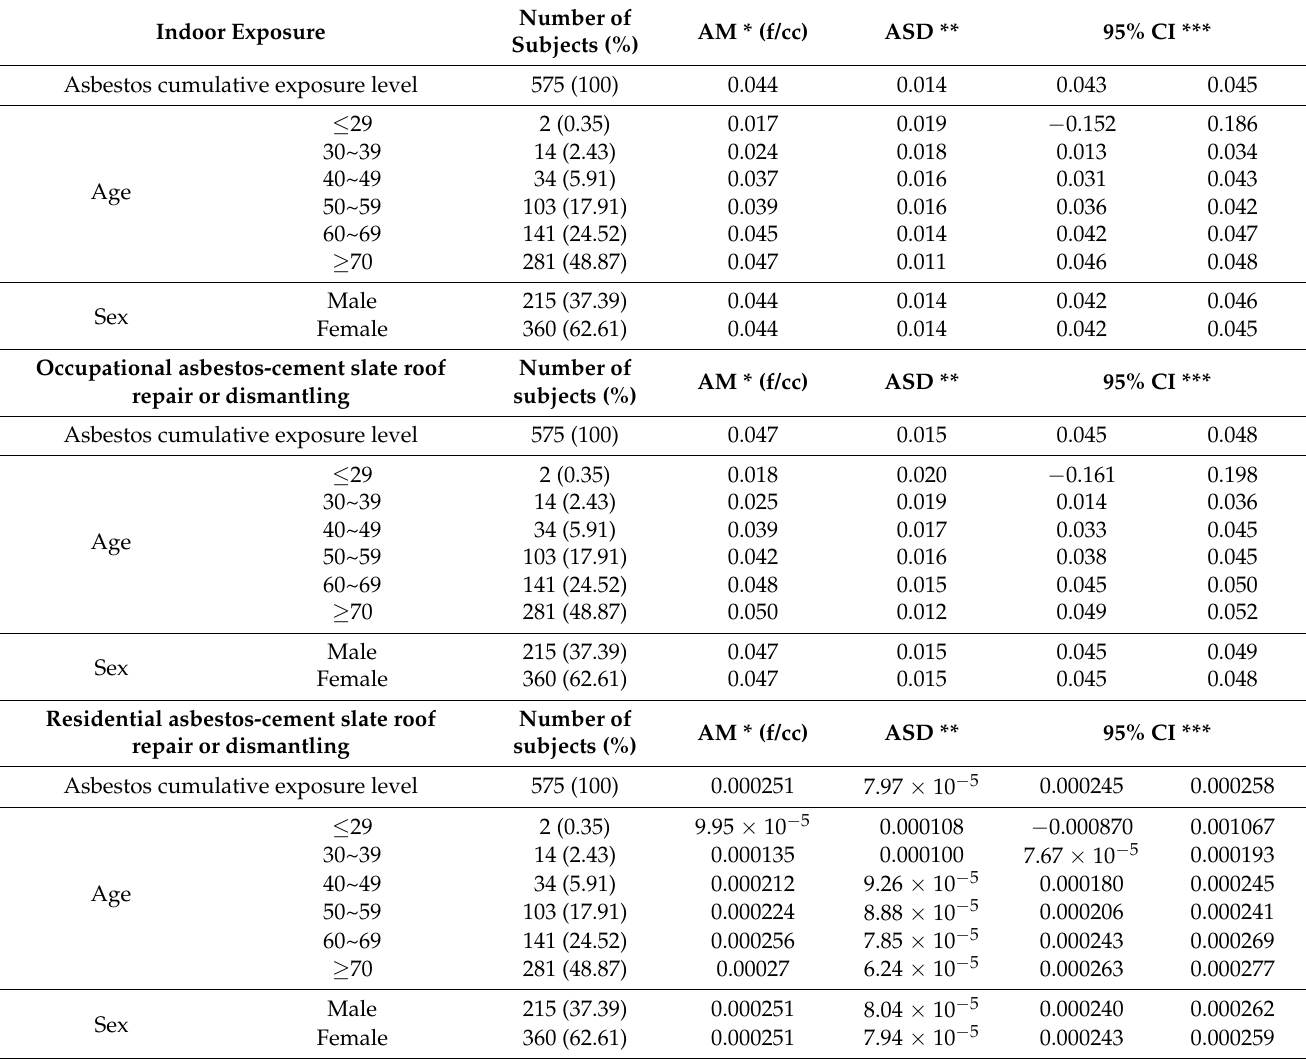
Table 4. Cumulative exposure level to asbestos by each asbestos-cement slate exposure scenario.